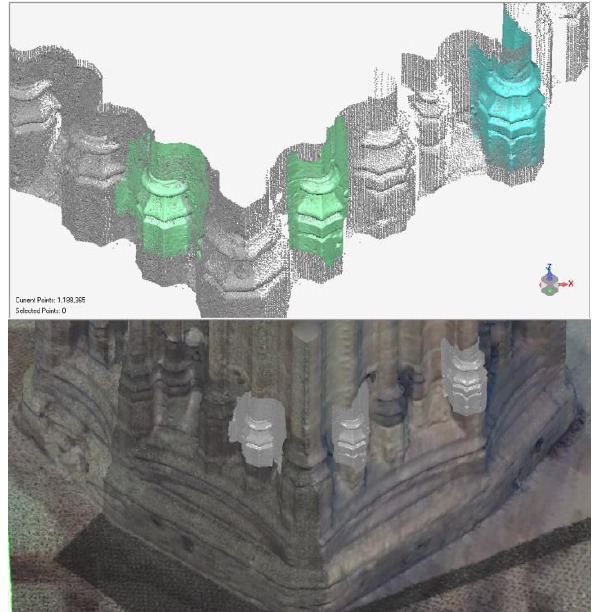
Figure 2. OS mesh placed on TLS point cloud (Cathedral of